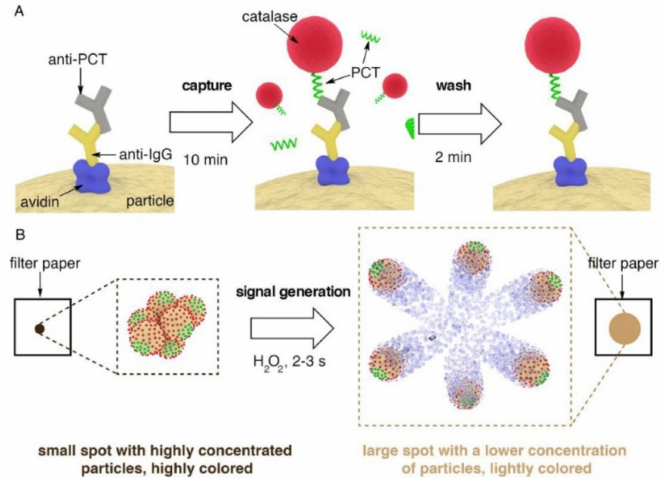
Figure 22. Schematic representation of the procedure for the rapid detection of PCT with the proposed multifunctional Janus particles; ( A ) PCT is specifically captured in blood utilizing a competitive immunoassay consisting of a 10 min capture step and a 2 min wash procedure; ( B ) signal generation mechanism: after spotting the particles on a piece of filter paper H 2 O 2 is added; the catalase enzymes generate bubbles that propel the particles and disperse the color within seconds. The subsequent change in pixel intensity is read in real-time with a mobile phone app. Reprinted with permission from ref. [214]. Copyright © 2019 Elsevier B.V.